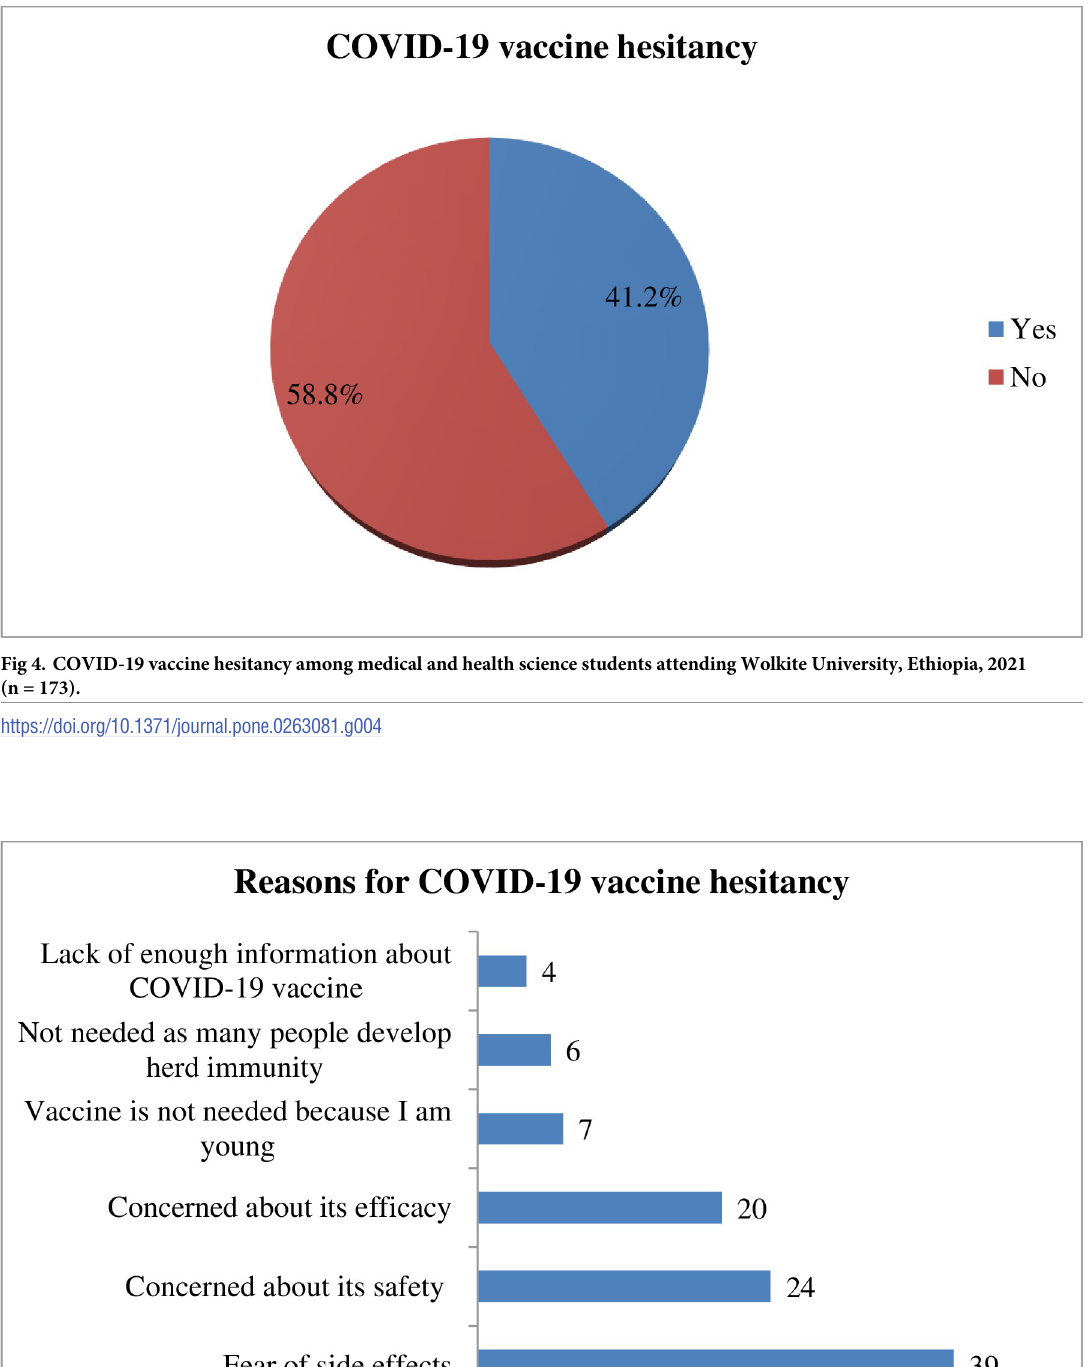
PLOS ONE | https://doi.org/10.1371/journal.pone.0263081 January 25,